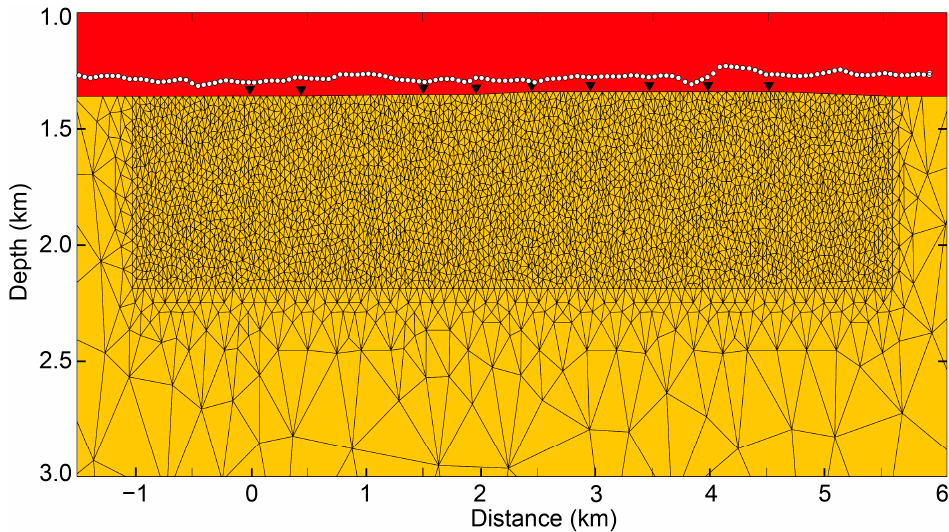
Figure 5. Closeup view of the core region below the receivers (black triangles). The seawater layers with a constant resistivity of 0.3 Ω · m were fixed in the model, and the seabed was assigned an initial resistivity of 1 Ω ·m. The white circles are the towed transmi tt ers pro fi le. The observed 8 Hz electric fi eld Pmax data were subject to 2D isotropic inversion by assigning an error fl oor of 5% of the maximum datum amplitude. The RMS fi tt ing di ff er- ence and model roughness were stable after the 22nd iteration, indicating that the inver- sion process was convergent, and the fi nal rms was 1.78. Although R3 site failed to capture electromagnetic fi eld data, data redundancy (following the principle of reciprocity) sug- gested that the R3 recovery failure had no impact on the last inversion result [29]. Figure 6a shows the amplitude data of the 8 Hz Pmax electric fi eld data (dots) and fi tt ed curves of the 22nd iteration, and the normalized residuals are shown in Figure 6b. As observed, the model response was well fi tt ed to the measured data after the 22nd iteration. There- fore, the resistivity model (Figure 7a) of the fi nal iteration was trustworthy and selected as the actual geoelectric structure.